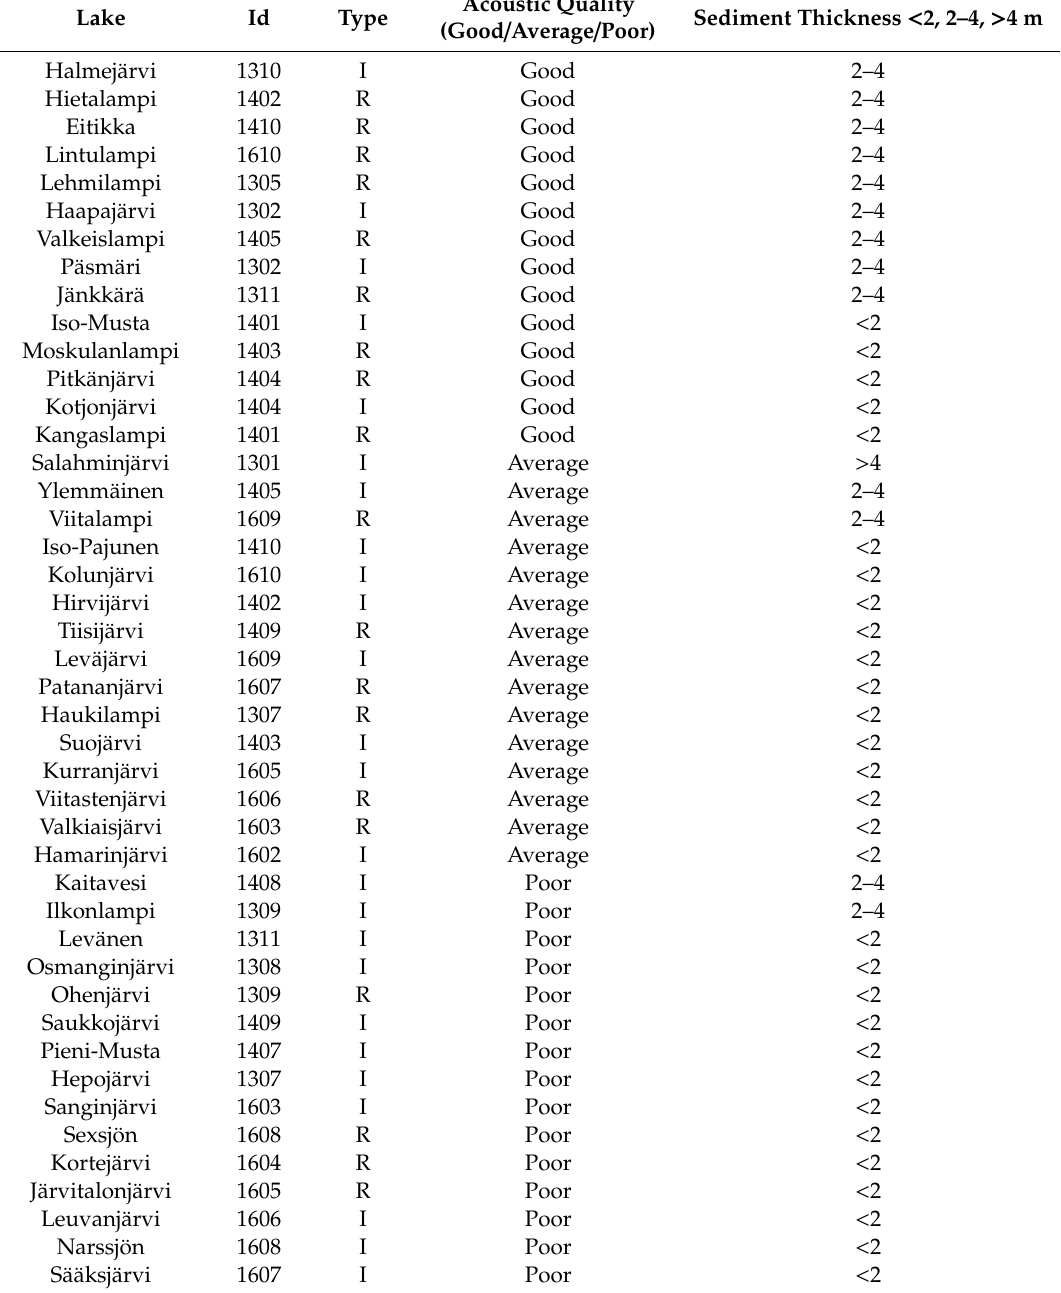
Table A1. Summary of acoustic profiles of the impacted and reference lakes in the present study.